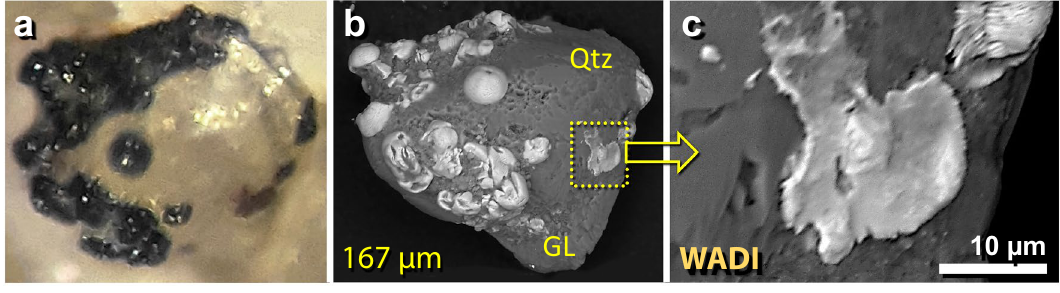
Figure 28. Fe-rich spherules embedded in meltglass. ( a ) Optical photomicrograph of a 167-µm-wide piece of meltglass with embedded Fe-rich spherules. ( b ) SEM image of same grain as in panel ‘ a ’. Melted quartz grain (Qtz) is embedded in Ca–Al–Si-rich matrix, which has the same composition as melted mudbrick. ( c ) SEM close-up image of the boxed area and panel ‘ b ’, showing splattered Fe-rich